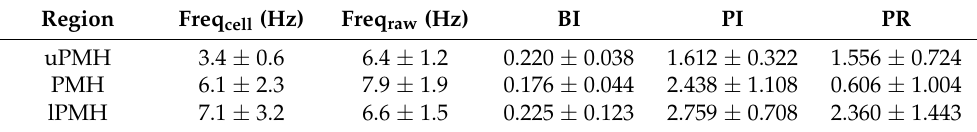
Table A3. Analysis of the discharge pattern computed at the three